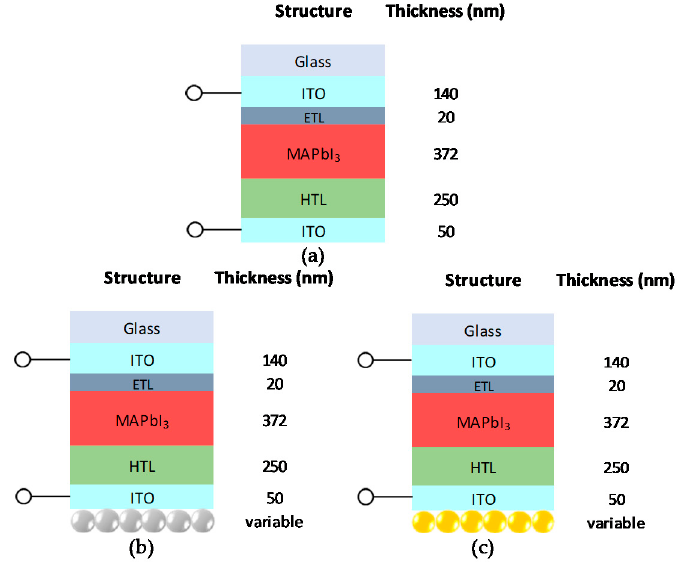
Figure 1. ( a ) Model of the semitransparent cell structure. ( b ) Model of the cell structure with added Ag NPs. ( c ) Model of the cell structure with added Au